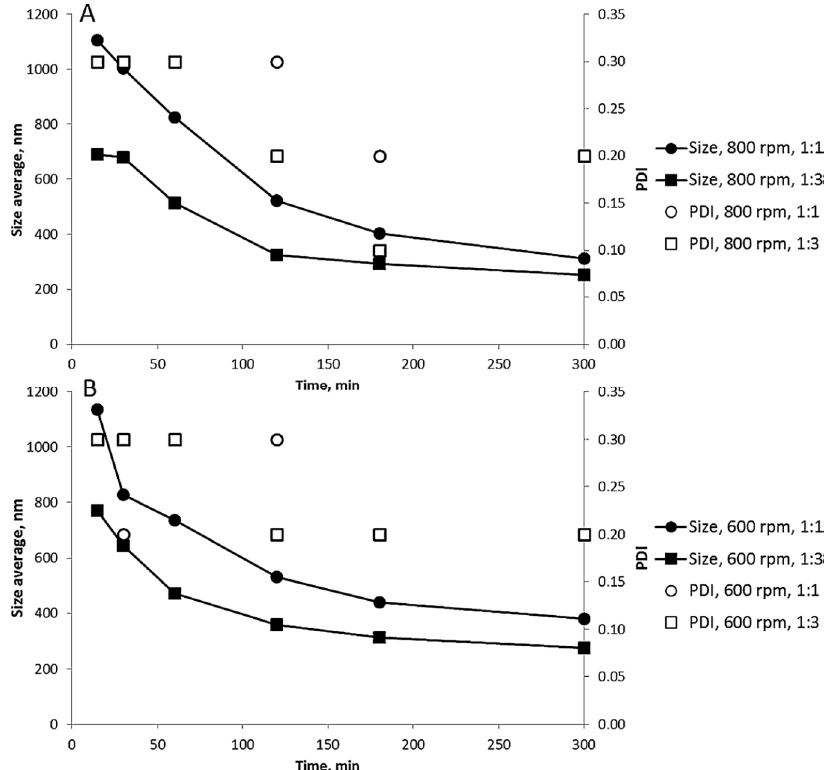
Figure 2. Effect of milling time, milling speed, and bead amount (suspension:bead ratio) on average particle size and polydispersity index of dexamethasone nanocrystals. Bead size: ( A ) 0.1 mm; ( B ) 0.3 mm. Reprinted from [63] with permission from Elsevier.